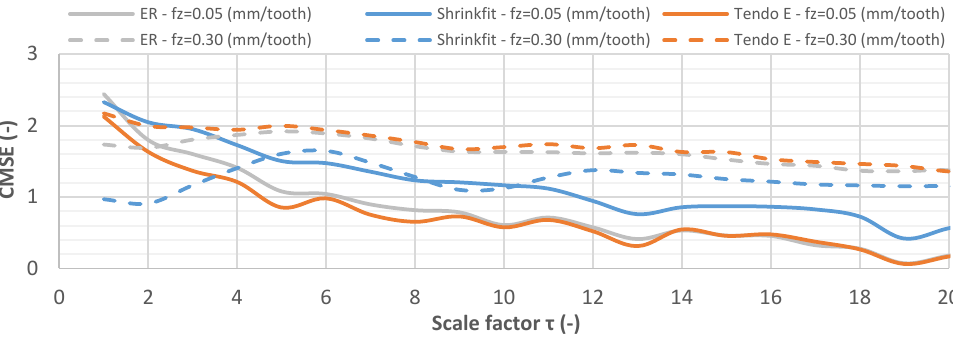
Figure 21. CMSE for vibration acceleration signals while milling at f z = 0.05 mm/tooth and f z = 0.30 mm/tooth (v c = 800 m/min, a p = 6 mm).